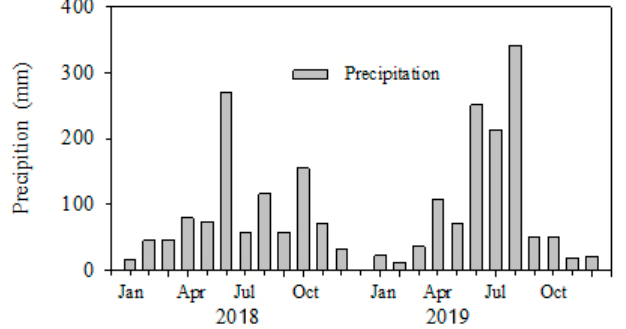
Figure 3. Monthly precipitation in experimental